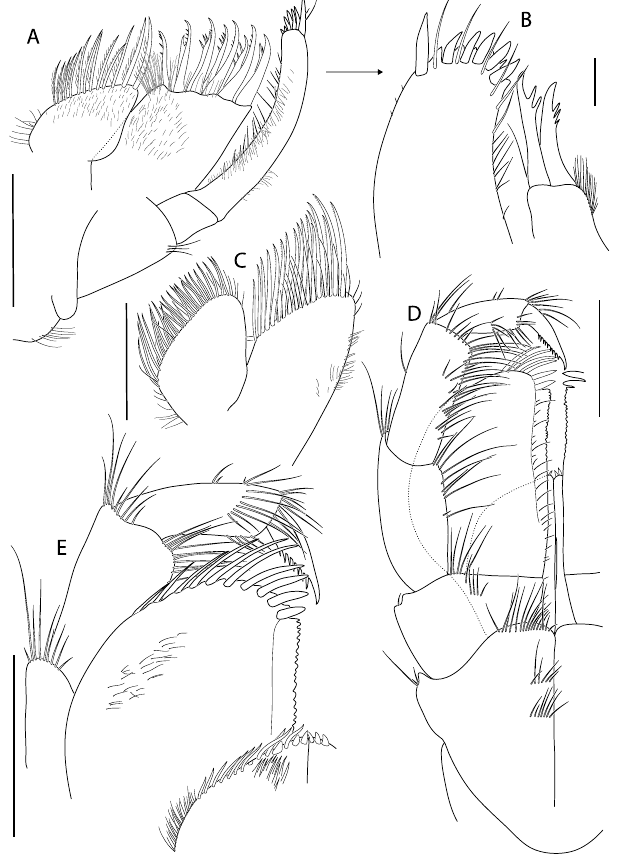
Labrum (“upper lip”; Fig. 15G) ventrally rounded. Hypopharynx (“lower lip”; Fig. 15C) with distally tapering lobes, densely coated with fields of setae on the medial margins. Mandible (Fig. 15D) with 8-dentate incisor; lacinia mobilis bifid (Fig. 15E); molar protruding and slender; mandibular palp (Fig. 15F) consisting of 3 articles, bearing long setae on the distal half of article 2 and the entire article 3 posteromarginally, setae length on palp article 2 and 3 increasing from proximal to distal. Maxilla 1 (Fig. 16A) inner plate sub-triangular, with 13 stout plumose setae along the medial margin; outer plate truncate, with 11 mediodistally serrated spines (Fig. 16B); palp 2-articulate, article 2 about 6 times longer than the 1 st article, curved inwards, distally serrate with 6 blunt spines and few subdistal setae (Fig. 16B). Maxilla 2 (Fig. 16C) inner lobe slightly broader and shorter than outer lobe, with numerous setae along the medial margin; outer lobe with a row of slender spines which are mediodistally serrate along with few short slender setae. Maxilliped (Fig. 16D,E) inner plate about 2/3 the length of 1 st palp article, apical ridge with blunt spines and stout setae; outer plate reaching about midpoint of palp article 2, ovoid, apical margin with slender spines which get stouter mediodistally, mediodistal region produced to a saw-like ridge; palp 4-articulate, mediodistal margin of article 1 with long setae, medial margin of article 2 strongly setose, article 3 with setae medio- and laterodis- tally, article 4 curved, with serrate medial margin. Gnathopod 1 (Fig. 17A) coxa tapering distally and having a rounded subangular apical tip, anterior margin sinuous, posterior margin straight to slightly convex and bearing a row of short very fine setae along medioapi- cally as well as longer setae subproximally; basis about as long as coxa, distinctly curved anteriorly, posteromar- ginally with tufts of long slender setae, anterior margin strongly setose with fine setae along its entire length; ischium slightly longer than wide, with tuft of setae posterodistally; merus with longitudinal articulation of car- pus, posterior margin oblique, with group of setae posterodistally; carpus distally slightly expanded, with dense setation along the posterior margin and a tuft of shorter setae anterodistally; propodus about 0.8 of carpus length, posteriorly with setae along the margin and on the lateral face; palm convex, with fine serration; dactylus curved, with serrate posterior margin. Gnathopod 2 (Fig. 17B,C) coxa slightly longer than coxa 1, tapering distally with a rounded subangular tip, anterior margin slightly sinuous, posterior margin distinctly convex medioapically with a row very fine short